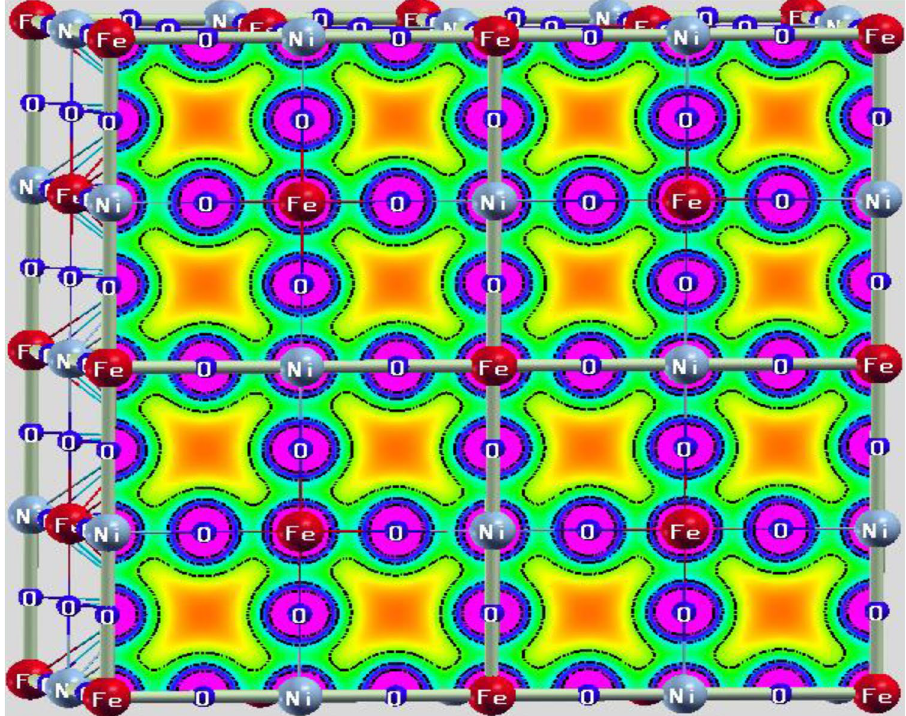
Figure 5. Charge density plot in (100)-plane for Ba 2 FeNiO 6 double perovskite.